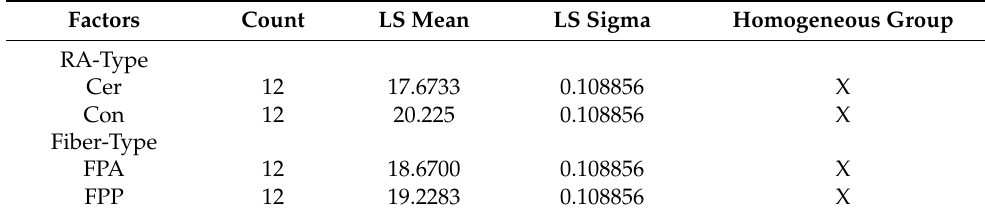
Table 12. Multiple range tests for Compression Strength (MPa). Factors Count LS Mean LS Sigma Homogeneous Group RA-Type Cer 12 17.6733 Con 20.225